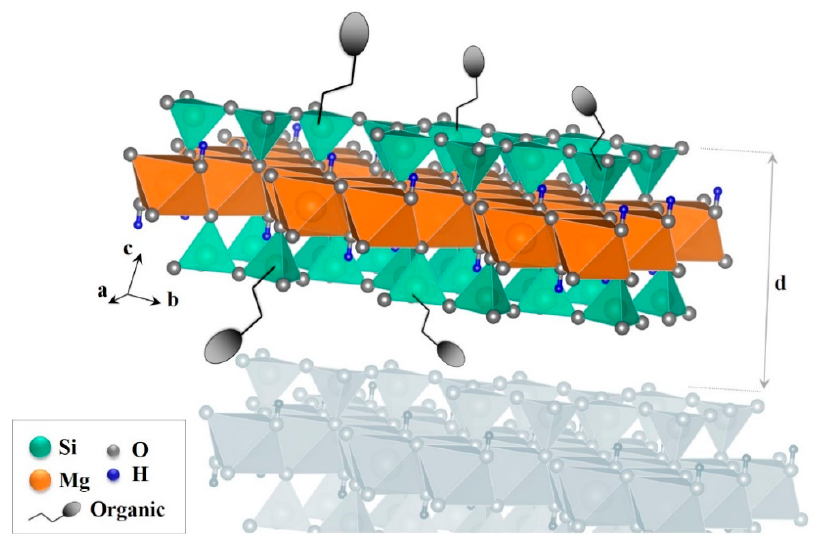
Figure 4. Structure of a standard organic–inorganic phyllosilicate obtained with a sol-gel process: d is the layer plus interlayer thickness.